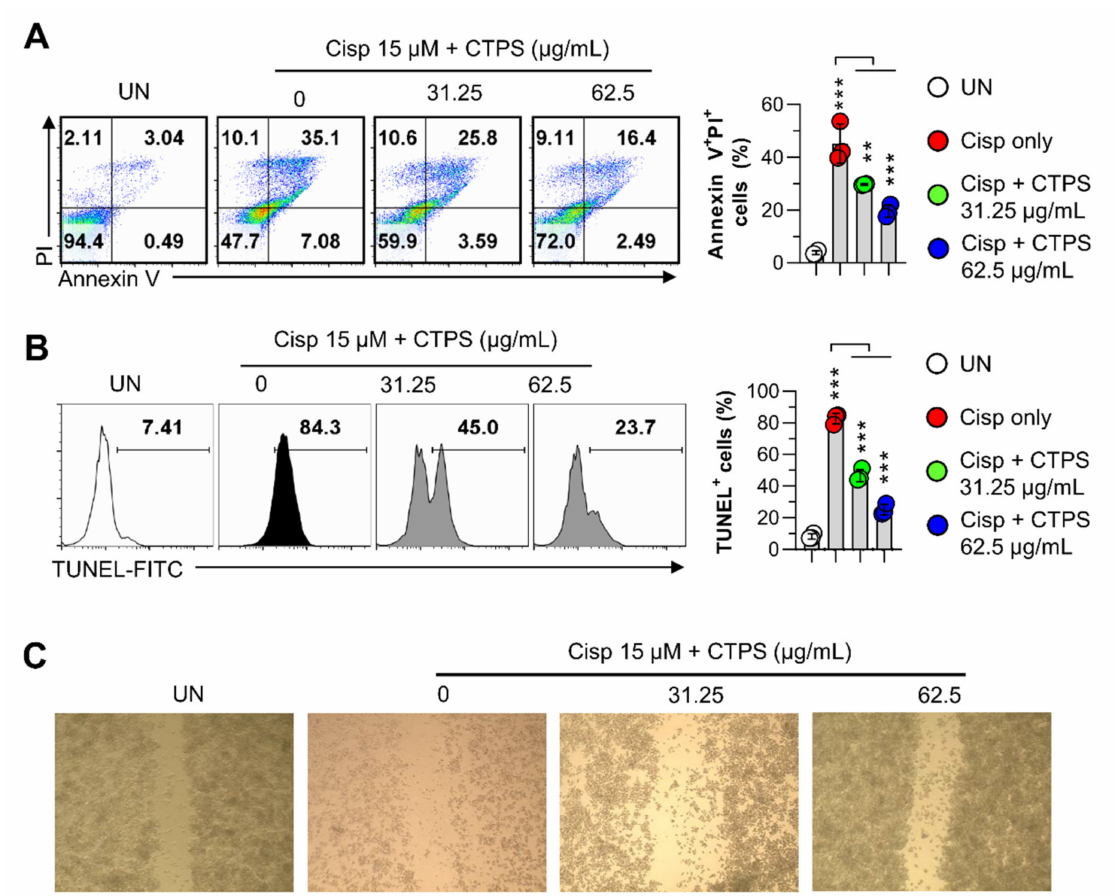
Figure 2. CTPS treatment decreases the cisp-induced macrophage apoptosis. ( A ) RAW264.7 cells were pretreated with CTPS (31.25 and 62.5 µ g/mL) for 2 h and then treated with 15 µ M cisplatin for 24 h. This was followed by flow cytometry analysis after Annexin V/PI (A) or TUNEL staining ( B ). The cells were analyzed via flow cytometry using the FACSVerse TM flow cytometer. ( C ) Cell migration was observed under a microscope. The data are expressed as the mean ± standard deviation ( n = 3). ** p < 0.01 or *** p < 0.001. UN, untreated cells; CTPS, Cudrania tricuspidata -derived polysaccharides; cisp, cisplatin; PI, propidium